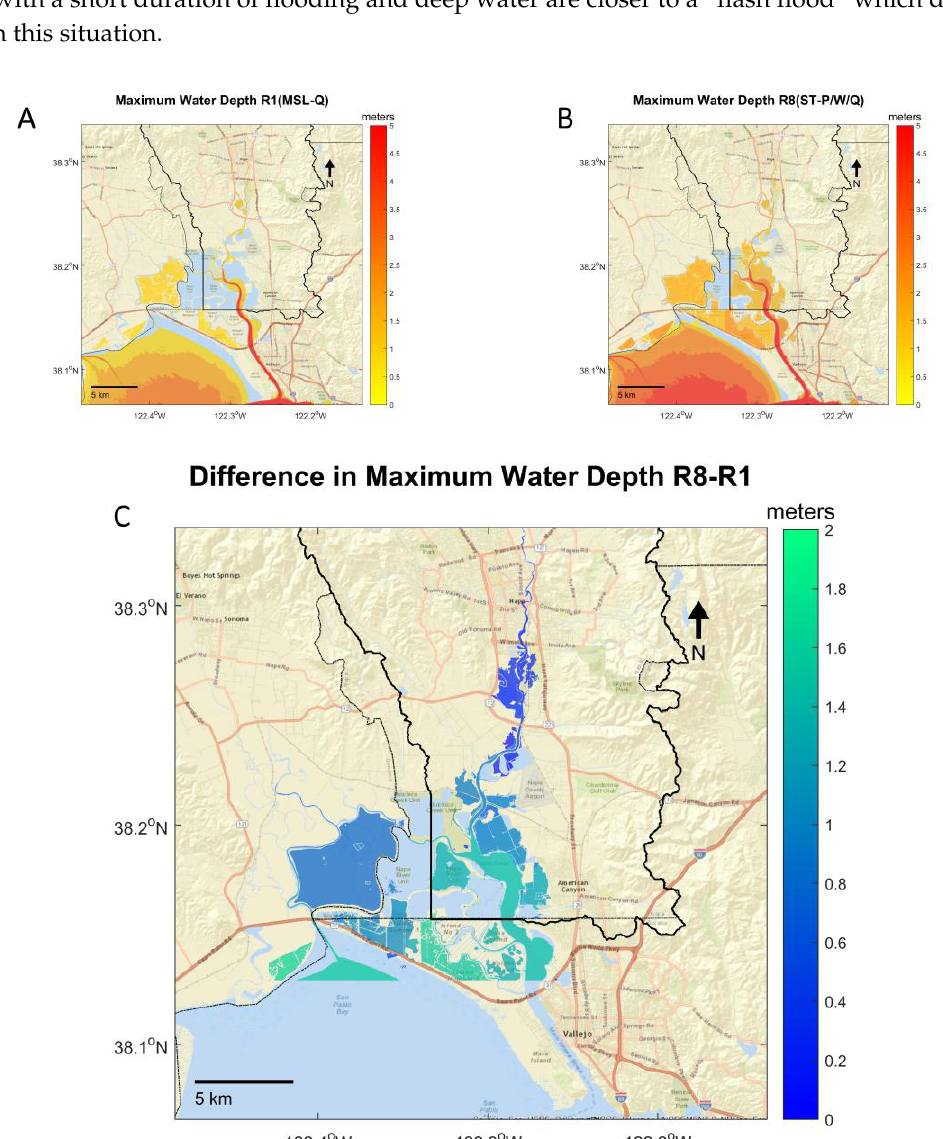
Figure 11. Comparison of modeled flood patterns accounting for river flows only and in combination with storm surge and tides. ( A ) Maximum water depth with a 5-year return period fluvial discharge and no tides (scenario R1). ( B ) Maximum water depth with a 5-year return fluvial discharge, 7-year return period coastally driven storm surge, and spring tides (scenario R8). ( C ) Increase in flood extent and water depth for scenario R8 relative to R1.